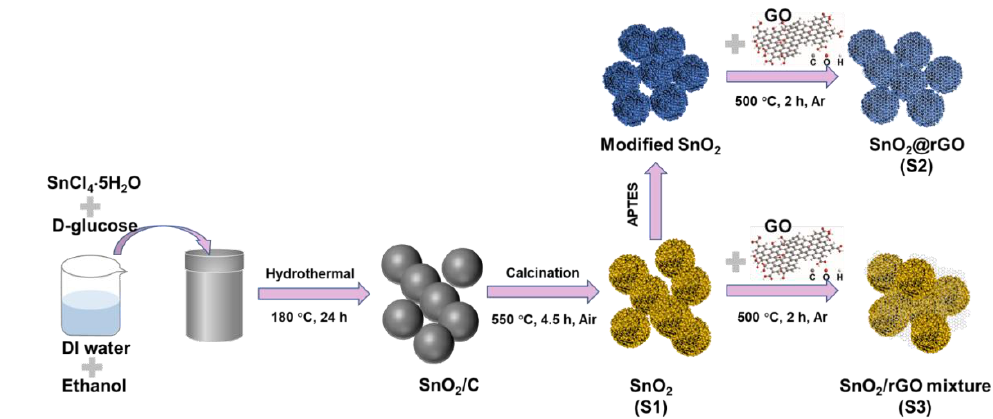
Figure 1. The schematic diagram of the synthesis process of S1, S2, and S3.